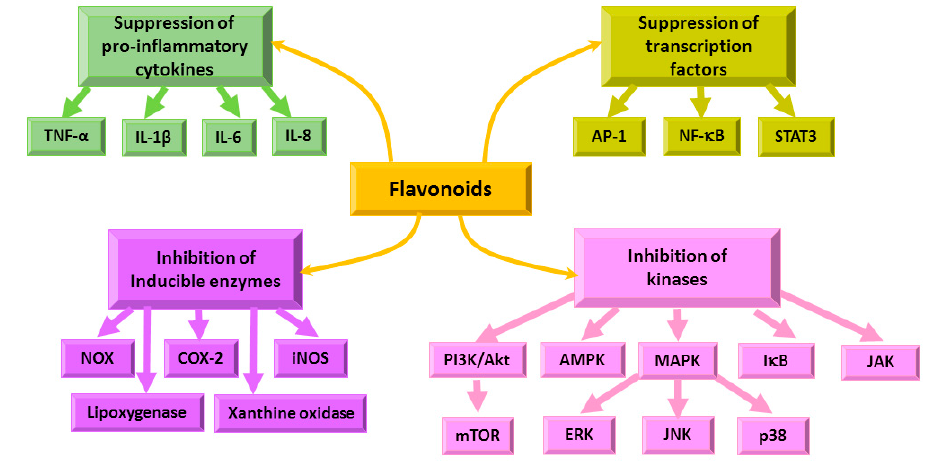
Figure 11. Flavonoid targets during inflammation processes. TNF—tumor necrosis factor,